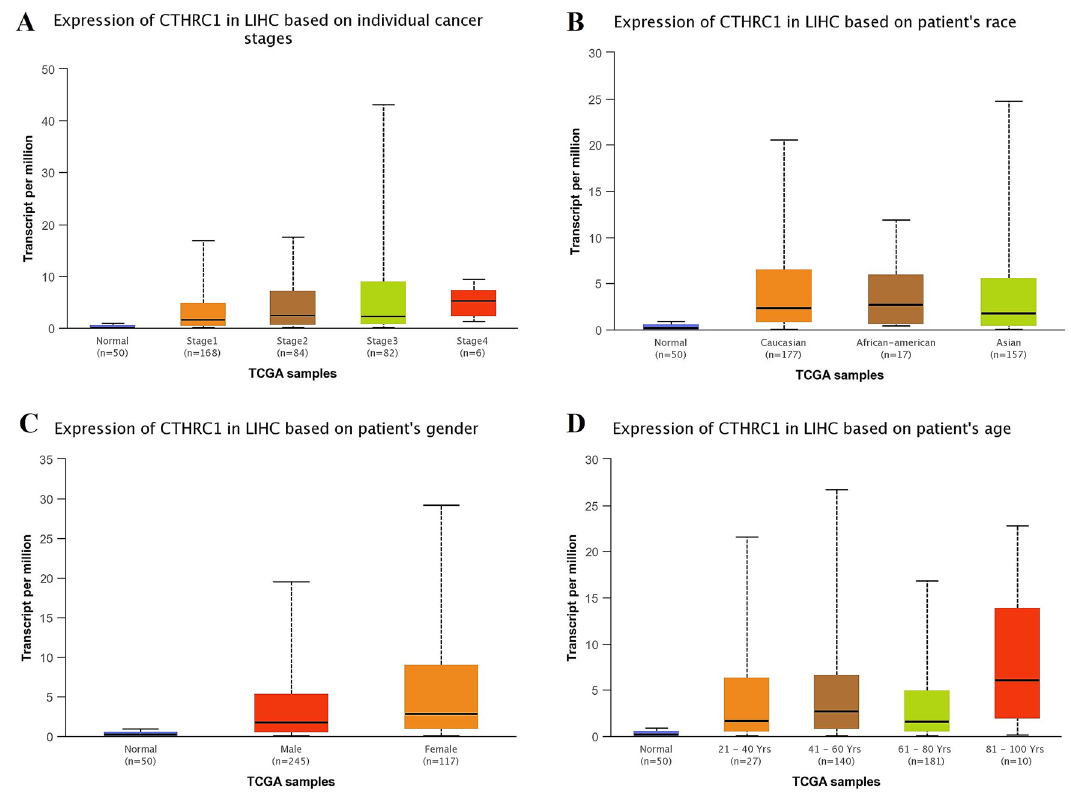
Figure 6. CTHRC1 transcription expression in various clinicopathological parameters of LIHC. ( A ) Different cancer stages based, ( B ) Different patients race based, ( C ) Different patients gender based, and ( D ) Different age groups based. A p-value of < 0.05 was selected as a cutoff